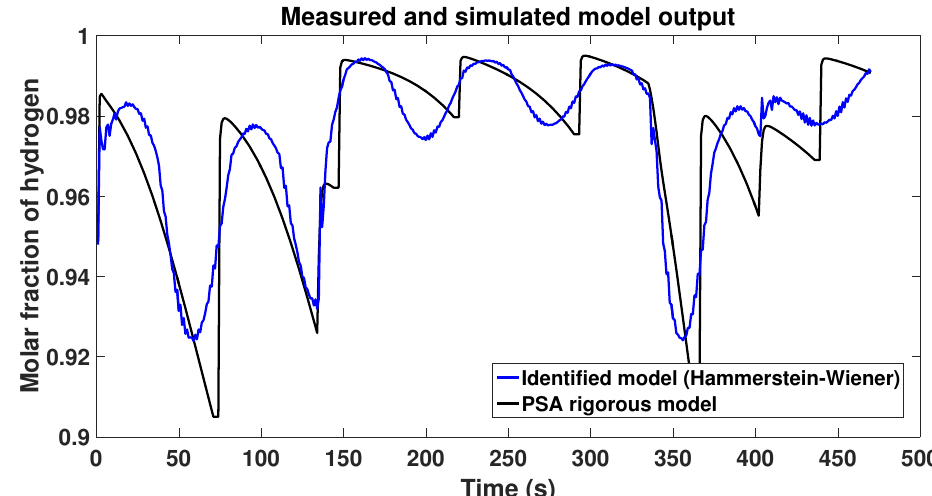
Figure 7. Comparison between the identified model and the rigorous model of the PSA process.